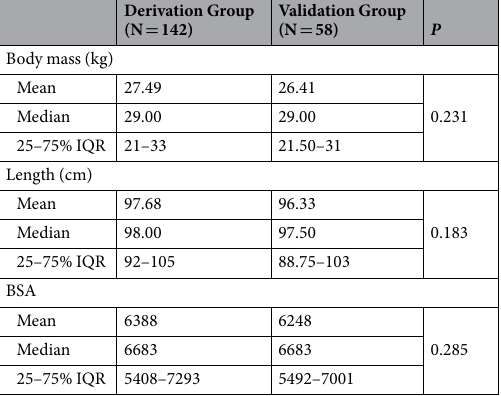
Table 1. Characteristics of Porcine Sample Groups. IQR, interquartile